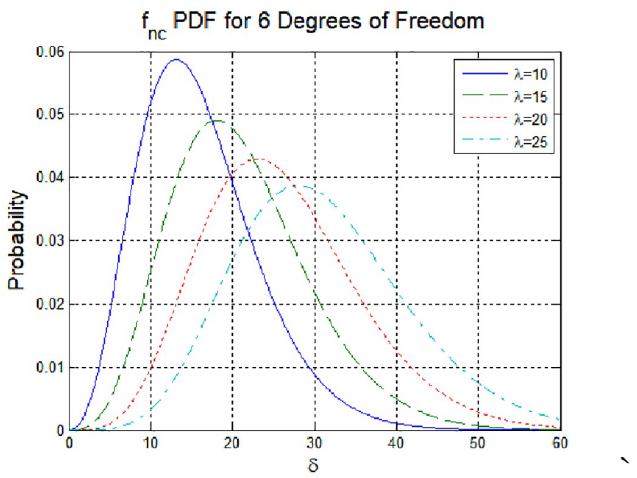
Fig 4. Non-central probability density function (degrees of freedom: